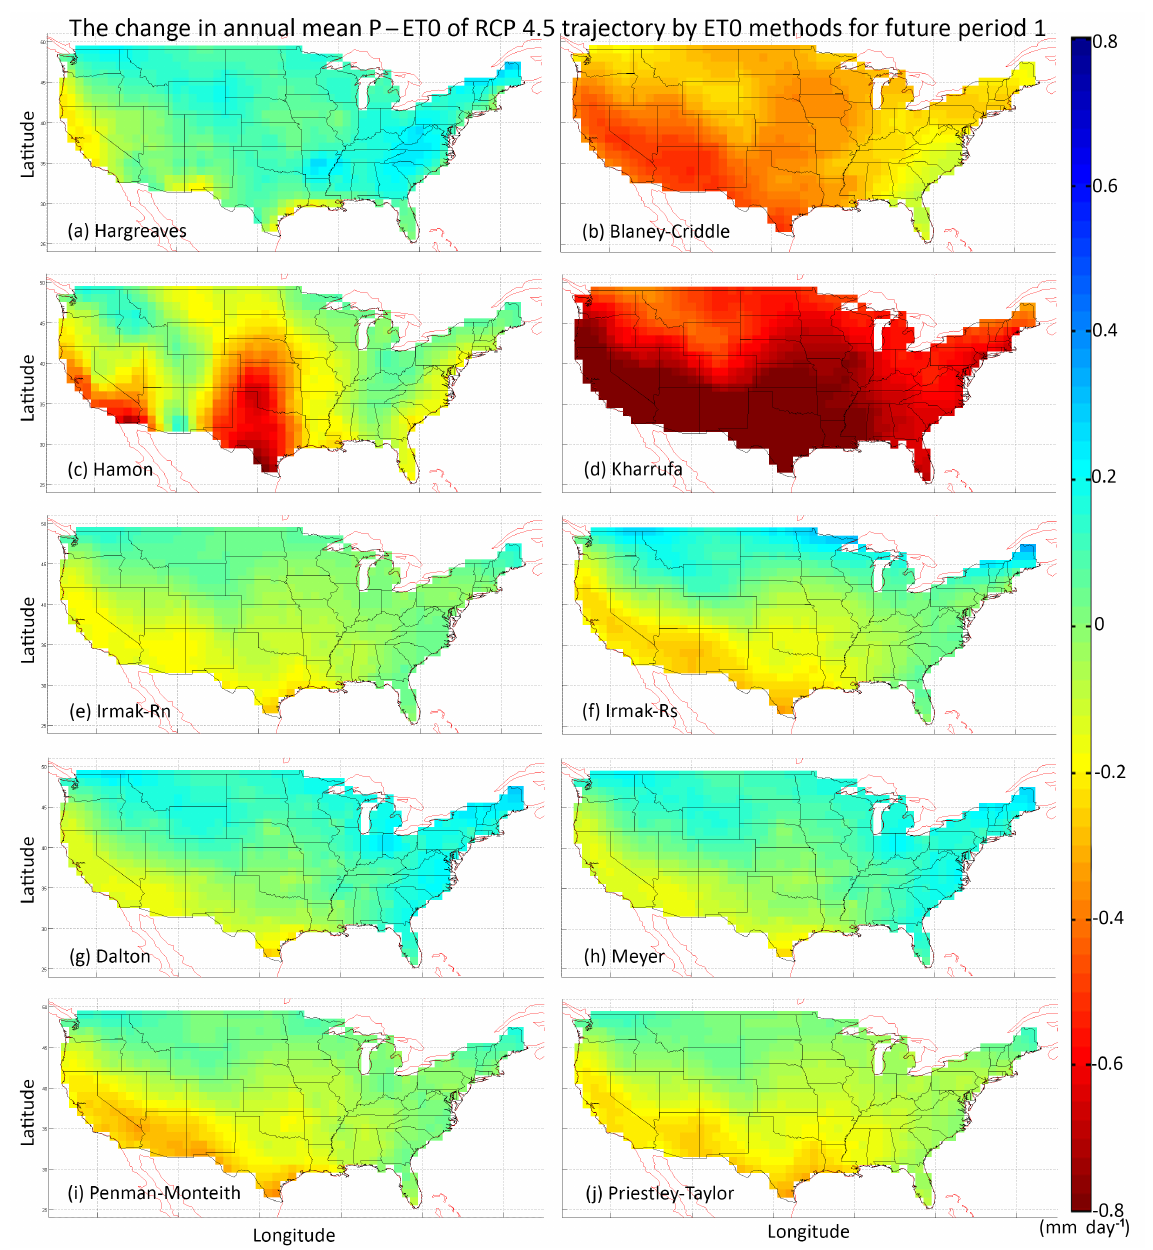
Figure 8. The change in the annual mean P –ET 0 of the RCP 4.5 scenario by 10 different evapotranspiration methods. All units are mmday − 1 and the change is defined as the mean of 2030–2060 minus that of 1950–2005. (All results are interpolated to 1 ◦ × 1 ◦ grids and averaged over nine different